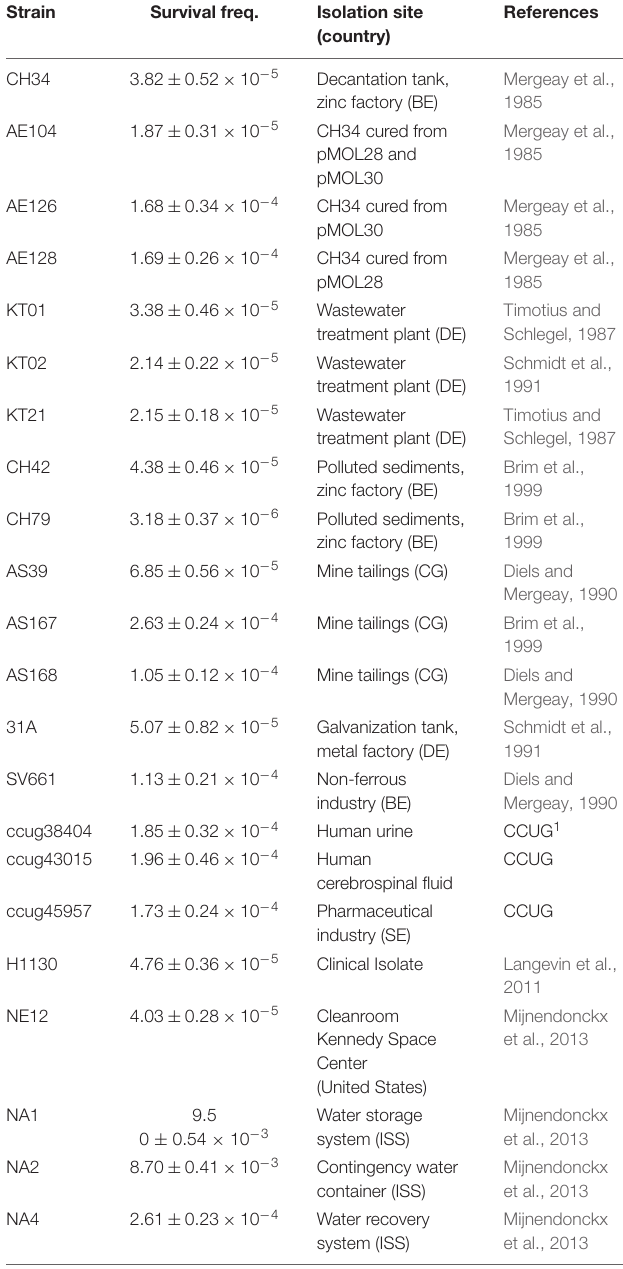
TABLE 2 | Survival frequency and isolation site/place of the different C. metallidurans strains used in this study as determined by the ratio of viable count on LB agar at 37 to 30 ◦